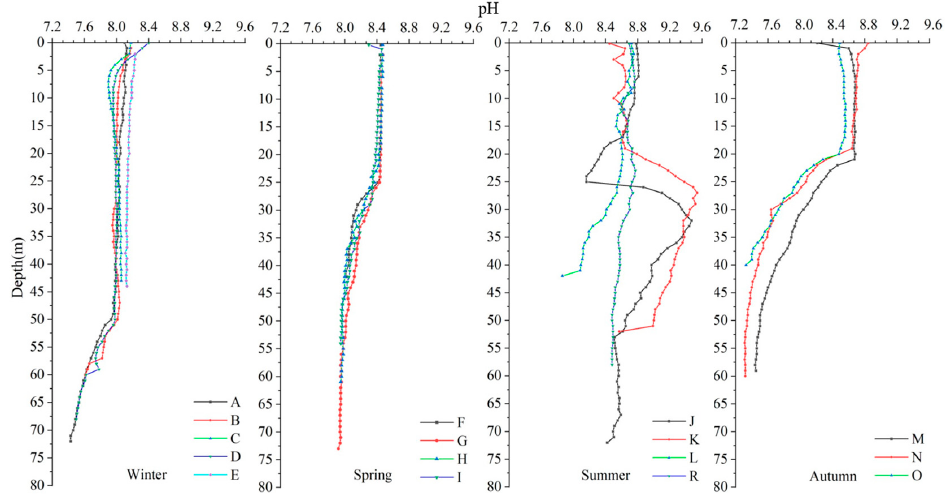
Figure 5. Seasonal variations of vertical pH section in Lake Lugu.